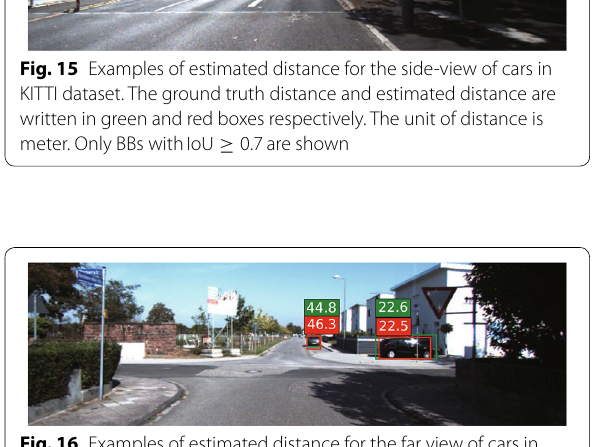
Fig. 16 Examples of estimated distance for the far view of cars in KITTI dataset. The ground truth distance and estimated distance are written in green and red boxes respectively. The unit of distance is meter. Only BBs with IoU ≥ 0.7 are